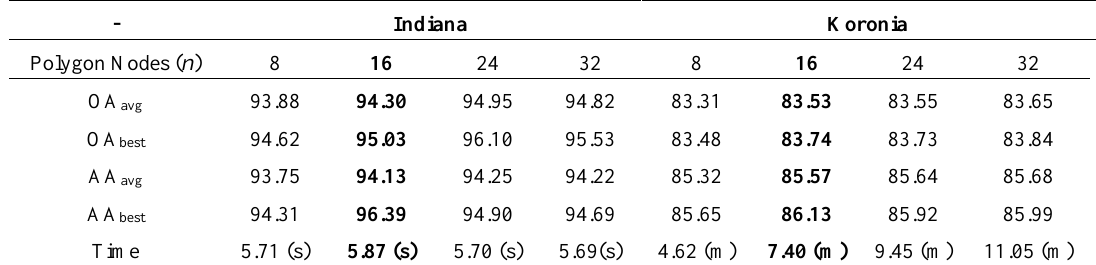
Table 9. Classification accuracies and execution times obtained by region-based GeneSIS for varying values of the number of polygon nodes. The experiments refer to the Indiana and Koronia images. The results corresponding to the selected parameter values are shown in